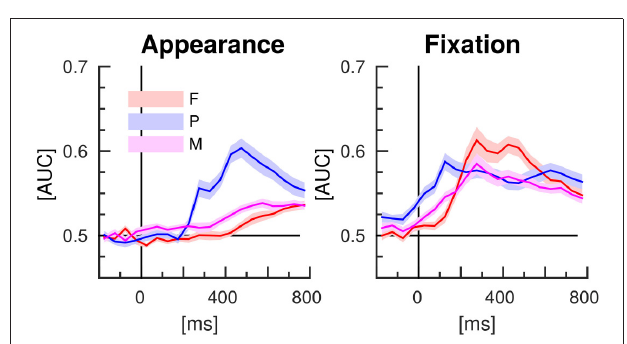
FIGURE 6 | EEG classification with spatial features (separate time-intervals at all channels). Lines indicate the mean AUC-scores of the 16 participants of the study and shaded areas stand for the standard error of the mean.